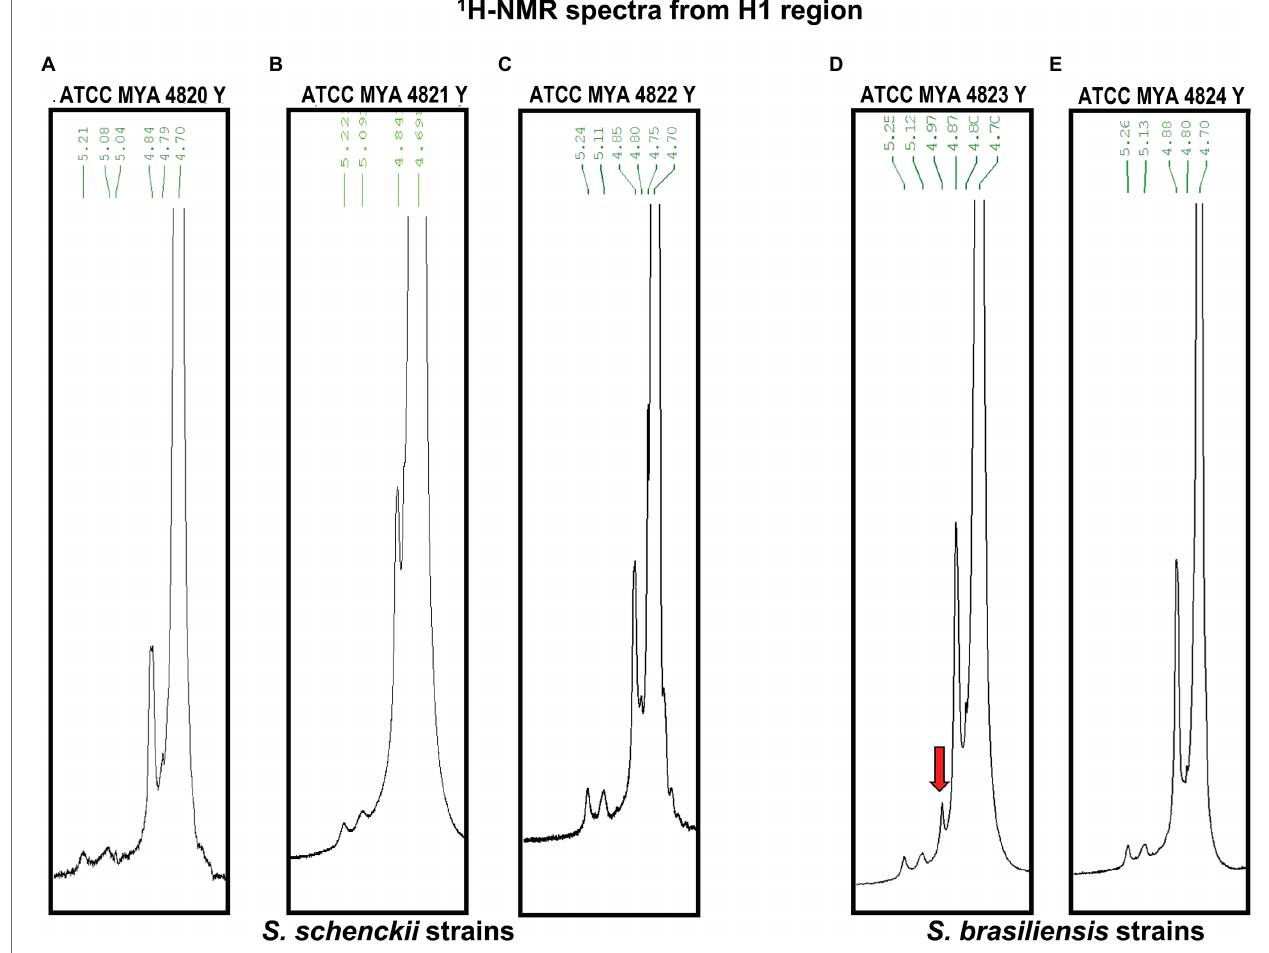
FIGURE 3 | 1 H-NMR of the rhamnomannan fraction isolated from S. schenckii and S. brasiliensis yeast cells. The H1 region of the rhamnomannans of S. schenckii (A–C) and S. brasiliensis (D,E) is enlarged. The red arrow shows a unique signal for S. brasiliensis strain 4823 as was described recently (Lopes-Bezerra et al.,